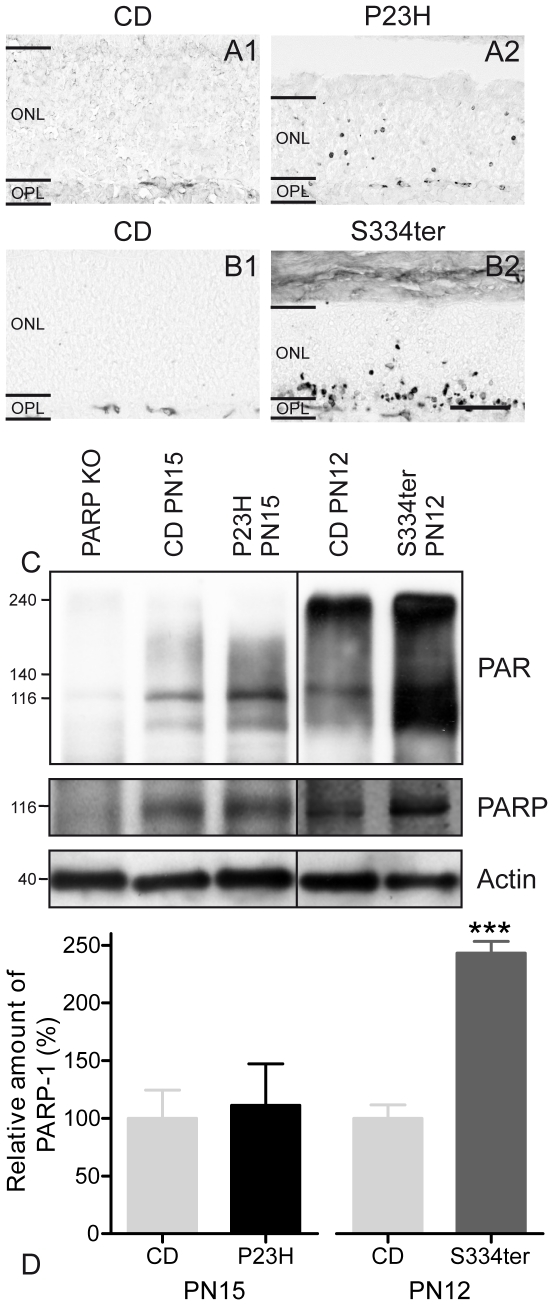
PAR accumulation and PARP-1 expression in rhodopsin transgenic rats.(A–B) Accumulation of PAR was found in many cells in P23H and especially in S334ter retinas. (C) PAR WB identified a band at ∼116 kDa which most likely represented PARP-1 itself and additionally strong labelling of proteins ranging from 100 to 240 kDa, suggesting poly(ADP-ribosyl)ation. Retinal PAR levels were increased in both transgenic animals. (C–D) PARP-1 protein expression was similar in wt and P23H retina, but significantly increased in S334ter. PARP-1 knock-out retina was used as negative control. Values are mean ± SD from four different experiments each containing retinas from 6 animals. ***P<0.001. Scale bar = 50 µm.